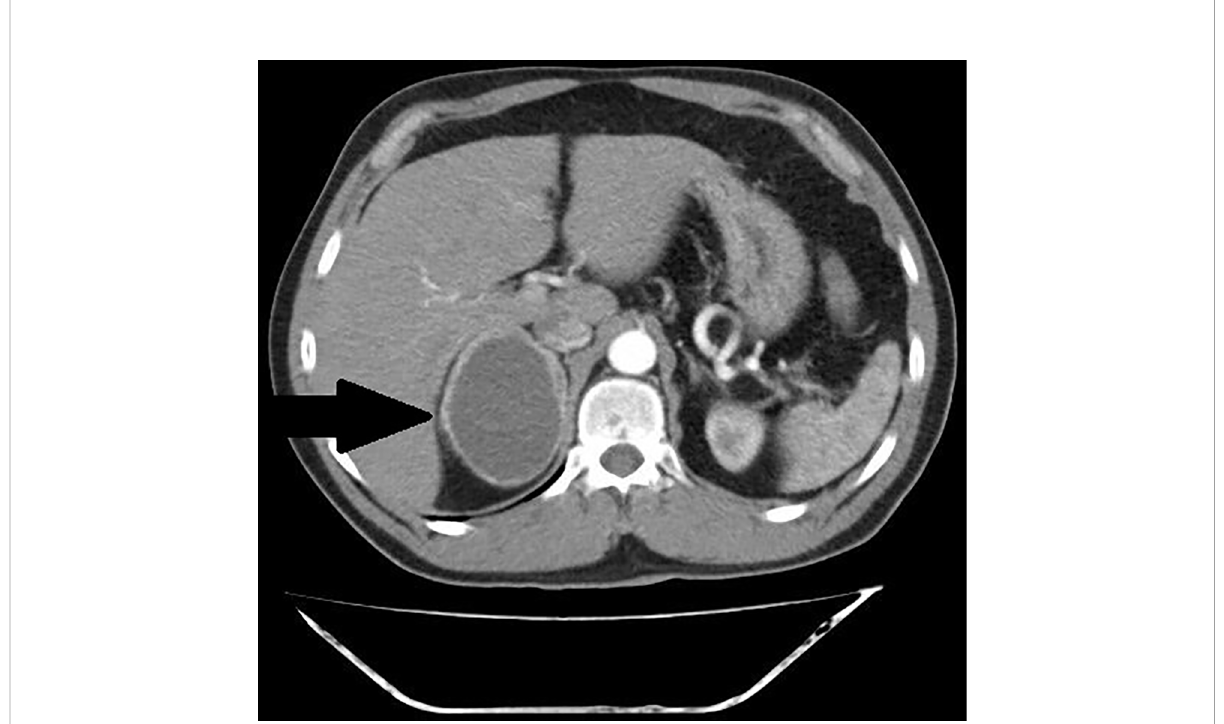
FIGURE 3 Patient number 4: CT of the abdomen, arterial phase, axial image- thick – walled hemorrhagic cyst of right adrenal gland with strong capsule- contrast enhancement (thick arrow).